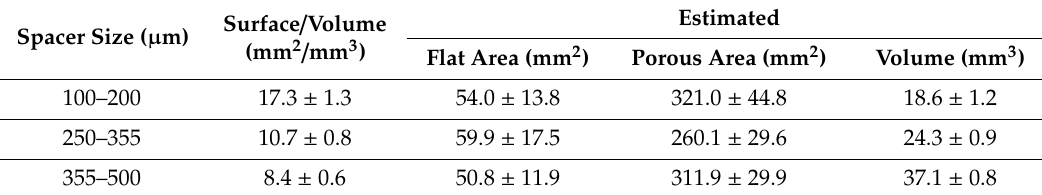
Figure 3. Distributions of di ff erent M-CT parameters for the three studied porous substrates (100–200, 250–355, and 355–500 µ m): ( a ) D eq vs. volume fraction, ( b ) distribution of the roughness volume percentage, and ( c ) D eq vs. roughness volume percentage. Inset: A rippled pore, the smoothed one and the volume di ff erence marked in color. Table 2. Microstructural characterization of porous substrates using M-CT analyses.